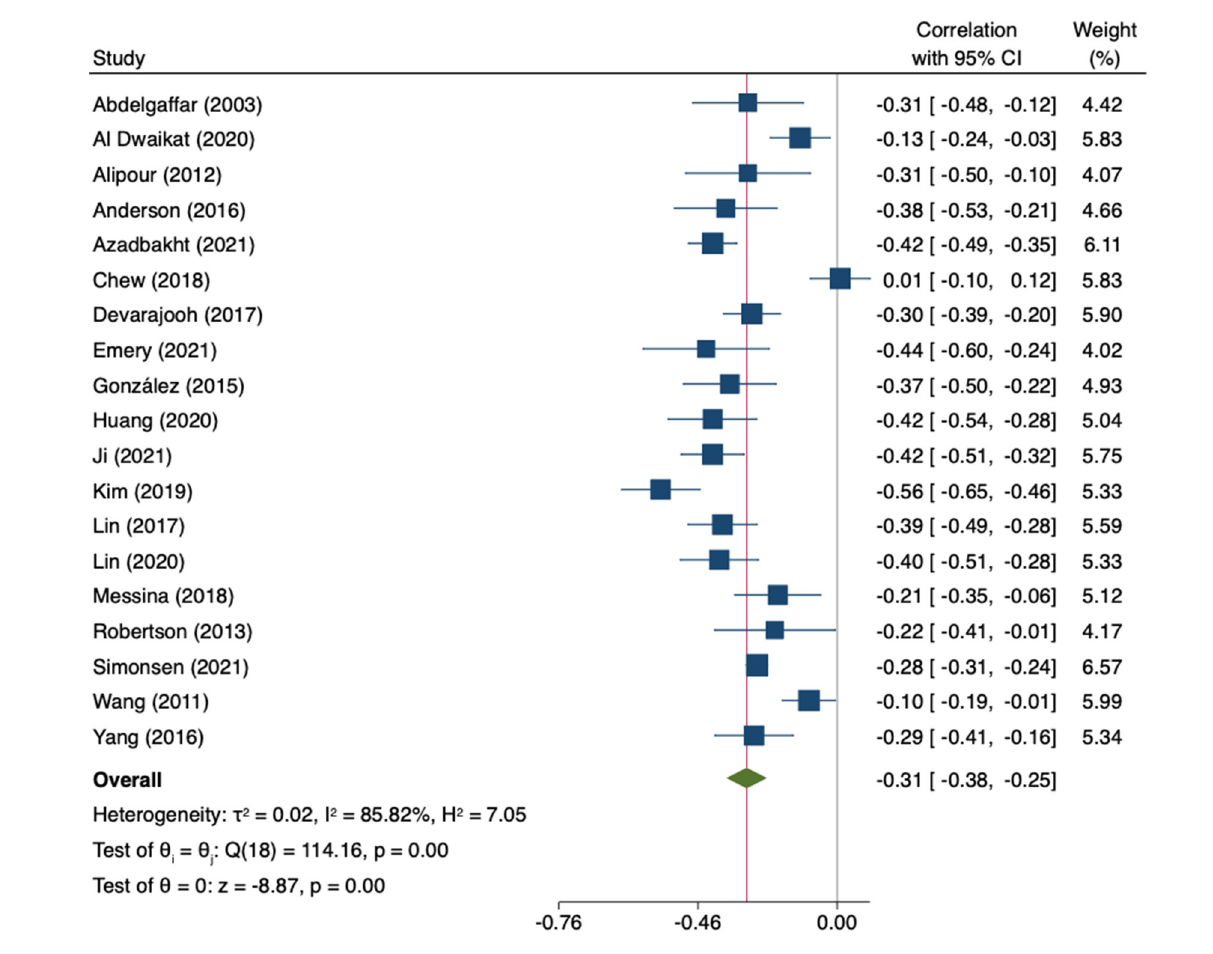
FIGURE7 Random-effects meta-analysis on the association between empowerment and